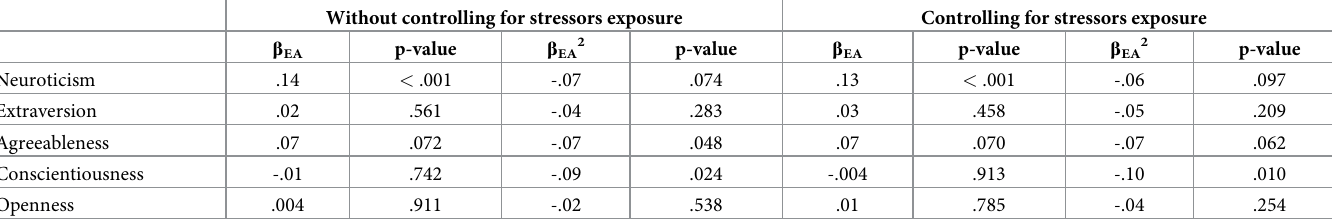
Table 3. Standardized estimates of the linear and quadratic effects of early adversity on personality traits with and without controlling for adulthood stressors exposure in the HRS sample.